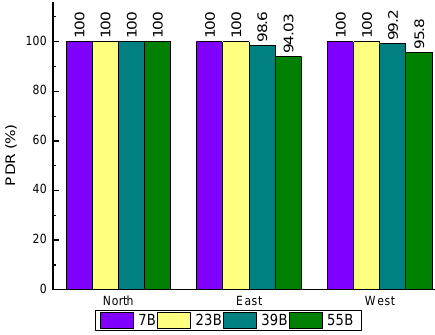
Figure 12. Relationship between packet delivery rate (PDR) and send power in the same floor.